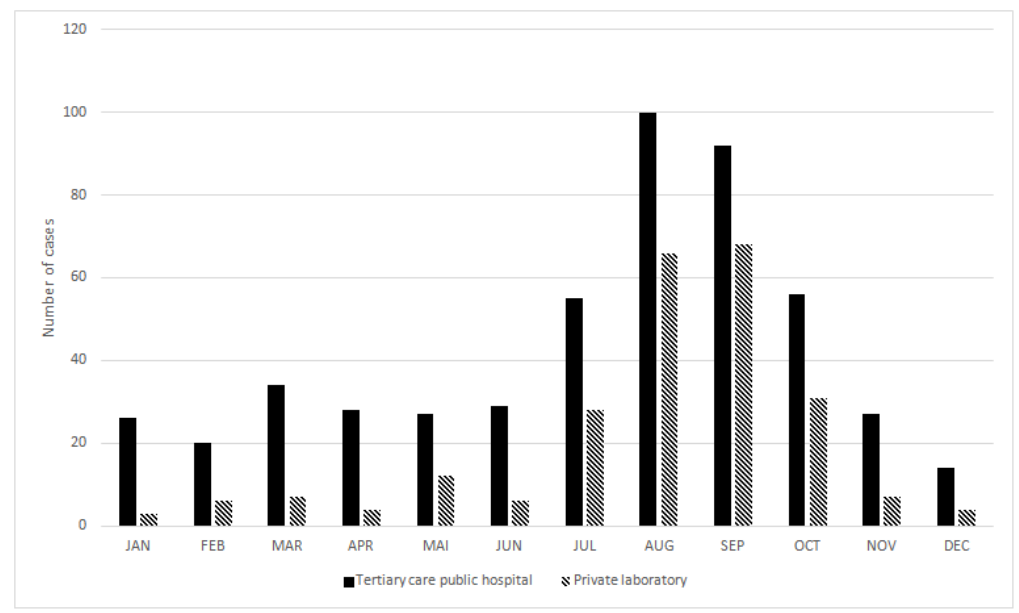
Figure 1. Annual distribution of cryptosporidiosis cases in France from 2017 to 2019.